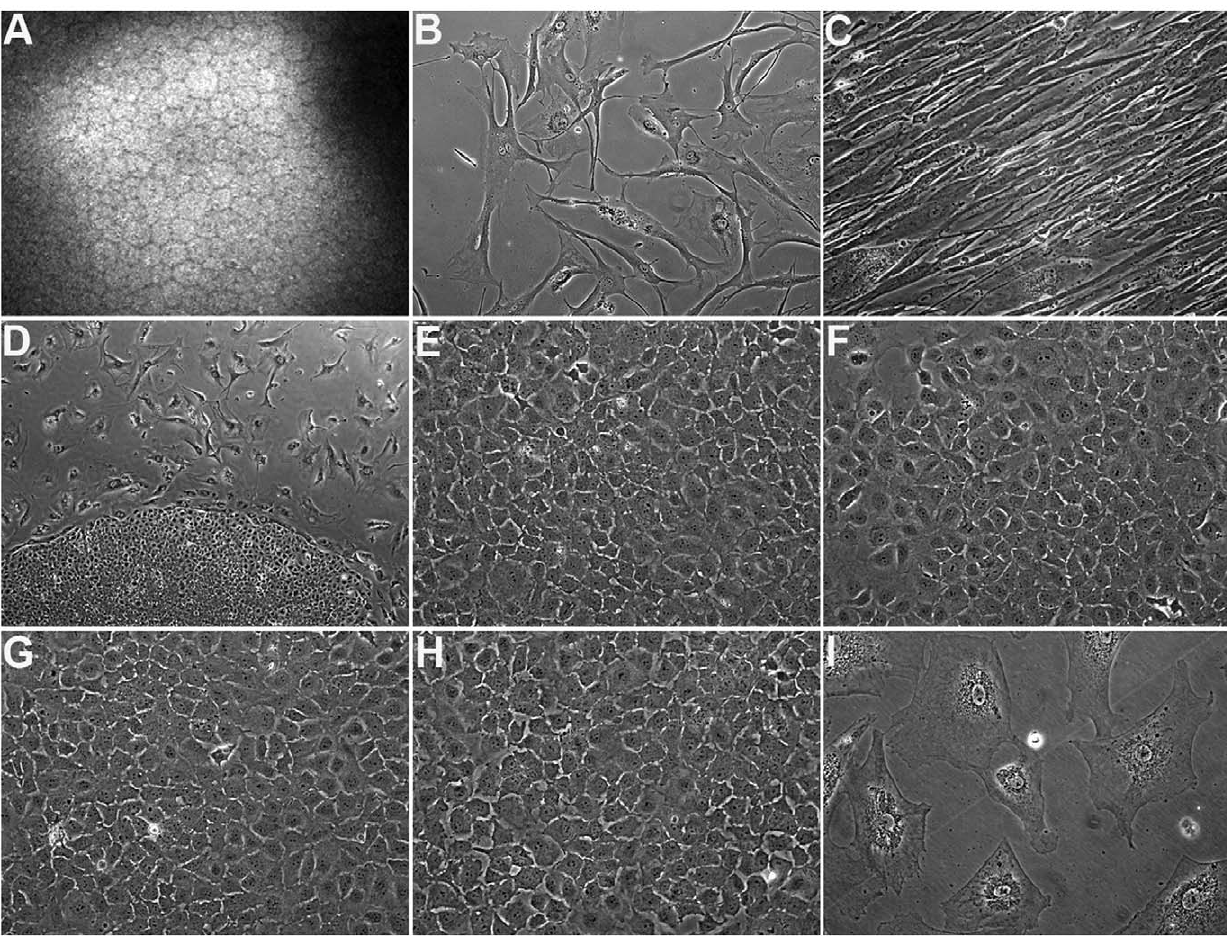
Figure 1. Morphologic study of corneal endothelial primary cells. (A) In vivo confocal microscopy of human corneal endothelium demonstrating the typical hexagonal cell morphology. (B) Phase-contrast micrograph of non-dividing primary cells from a 21-year-old donor (21M) at passage 9, displaying typical signs of senescence. 200x. (C) Phase-contrast micrograph of primary cells from a 63-year-old donor that underwent endothelial-mesenchymal transformation at passage 1. Note that the cells lost the typical corneal endothelial morphology and appear fibroblast-like. 200x. (D) Phase-contrast micrograph showing 2 morphologically distinct subpopulations of cells in the 21M primary culture. The uniform cells growing in colony-like structures were designated HCEnC-21. 40x. (E-H) Phase-contrast micrographs of HCEnC-21 at passages 24 (E) and 46 (F) as well as telomerase-transduced HCEnC-21 (HCEnC-21T) at passages 25 (G) and 50 (H). Importantly, HCEnC-21 and HCEnC-21T cells grew in contact- inhibited monolayers displaying the typical hexagonal cell morphology seen in vivo. 200x. (I) Phase-contrast micrograph of telomerase-transduced 21M (21M + hTERT) at passage 7 showing a senescent phenotype. 200x.